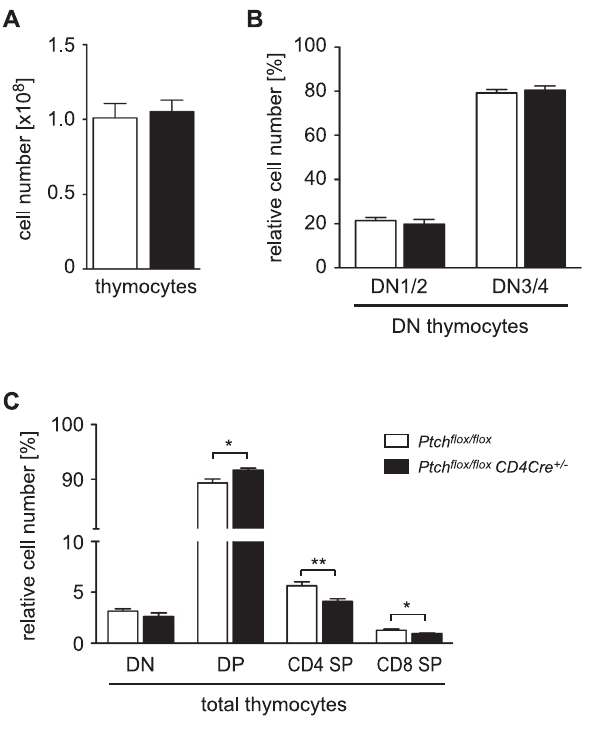
Figure 1. Flow cytometric analysis of thymocyte development. Thymocytes were isolated from Ptch flox/flox control or Ptch flox/flox CD4Cre + / 2 mutant mice, counted and stained for CD4, CD8, and CD44 to identify different developmental stages. (A) Mean number of total thymocytes 6 SEM is shown for four mice of each genotype. (B) Percentages of CD4 2 CD8 2 CD44 + (DN stages 1 and 2) or CD4 2 CD8 2 CD44 2 (DN stages 3 and 4) thymocytes amongst total DN thymocytes are depicted. (C) Percentages of DN, DP and CD4 SP or CD8 SP cells amongst total thymocytes are shown. Panels B and C refer to the mean 6 SEM of four mice of each genotype. Statistical analysis was performed by unpaired t-test (*: p , 0.05). Differences were not statistically different unless otherwise